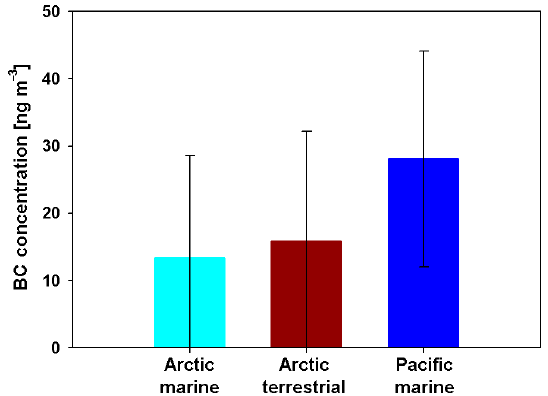
Figure 8. Average mass concentrations of black carbon for each air